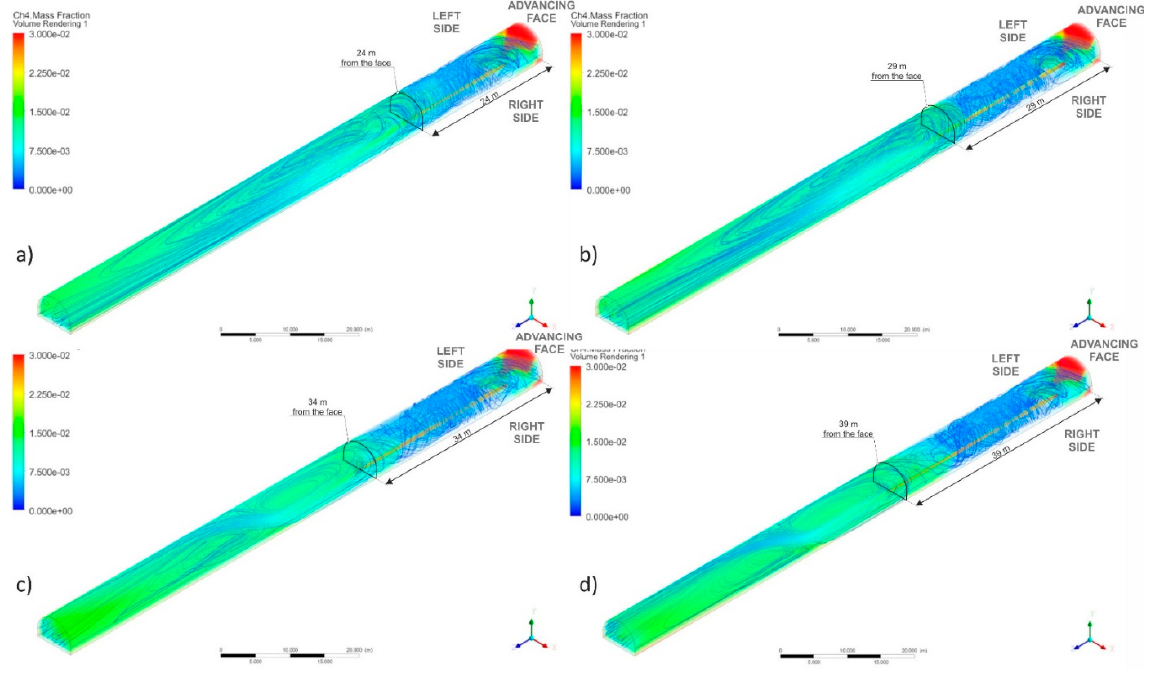
Figure 9. Methane concentration and velocity streamlines—general view, ( a ) L o = 5 m, ( b ), L o = 10 m, ( c ), L o = 15 m, ( d ) L o = 20